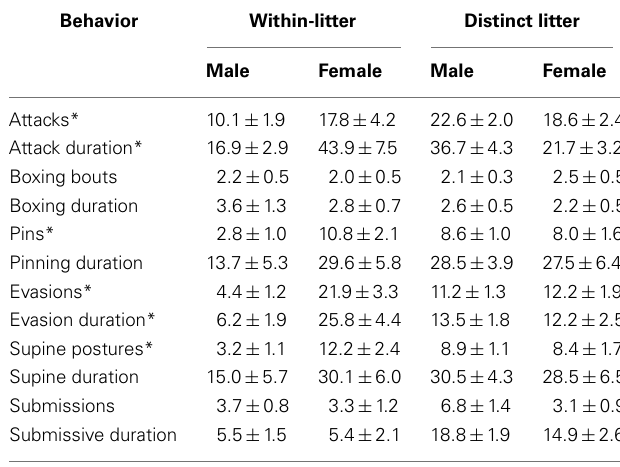
Table 2 | Comparison of within-litter (“stay-at-home”) and distinct control subjects on mean number ( + SEM) and mean total duration (seconds + SEM) of play behavior measures in male and female adolescent